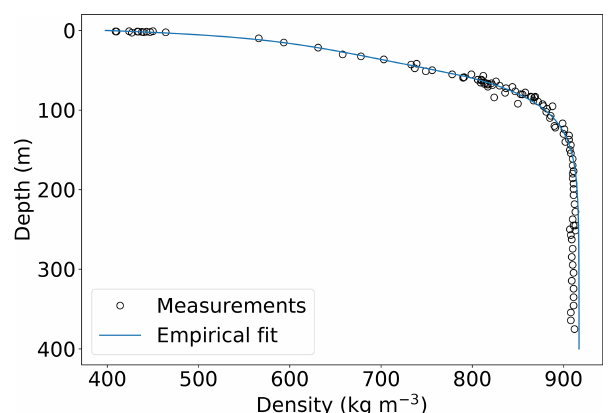
Figure 5. DSS density profile, observations (circles) and empirical fit (solid line calculated using Eq.